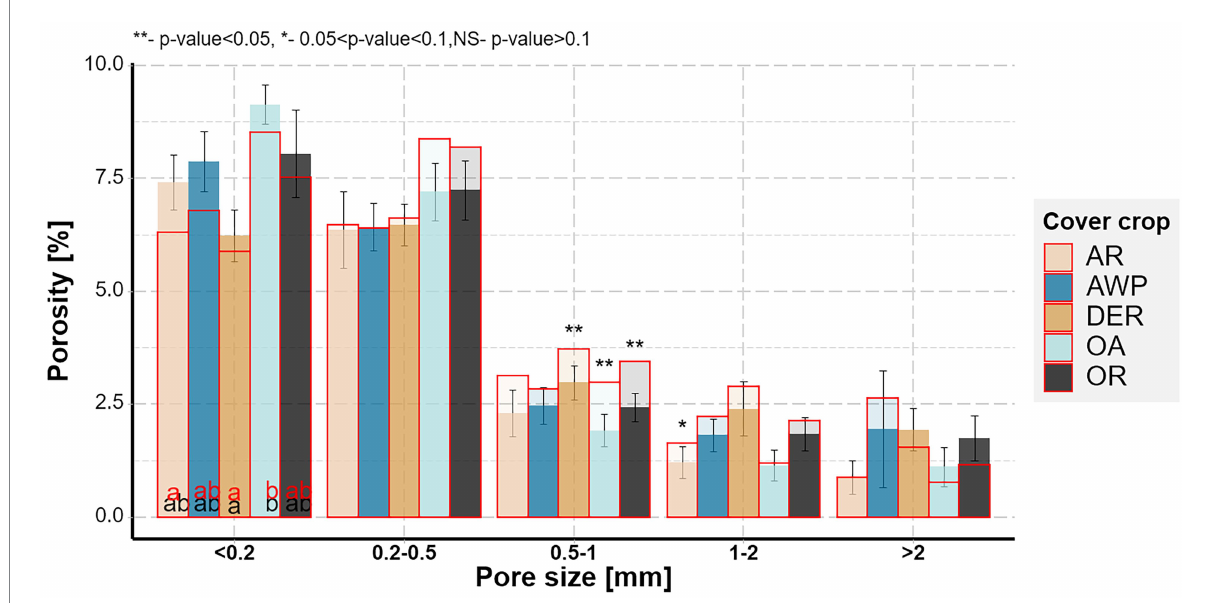
FIGURE 2 Soil pore size distributions for the five studied cover crops after the 1st (outlined in red) and the 2nd root growing period (multiple fill colors). Letters indicate significant differences between plant species within each size class for the 1st (red) and 2nd (black) growing period ( p < 0.05). Stars above the bars show significant differences between the two growing periods. Whiskers show standard errors of the means after the 2nd growing